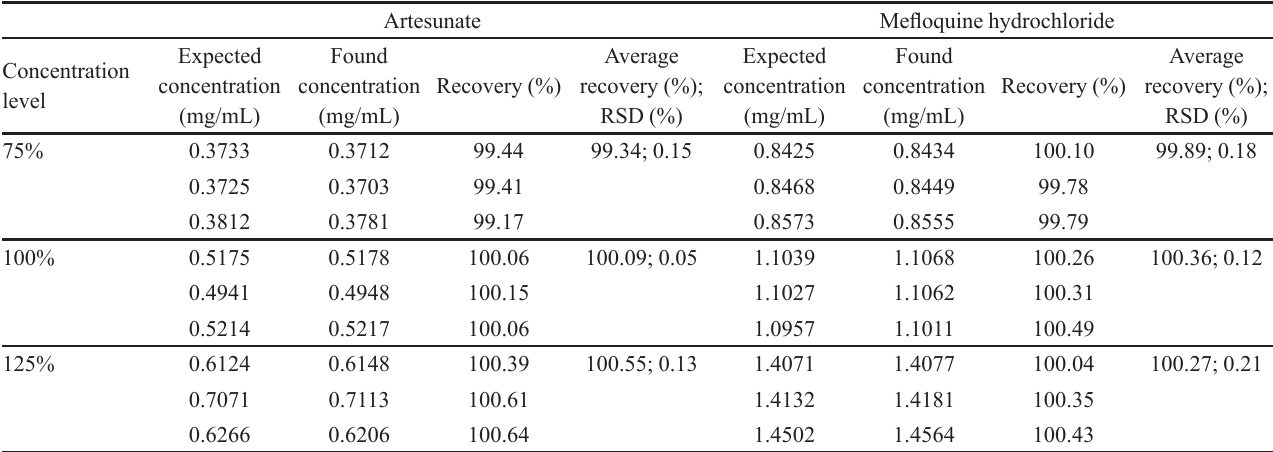
TABLE III - Results of the recovery analysis of AS and MQ in tablets